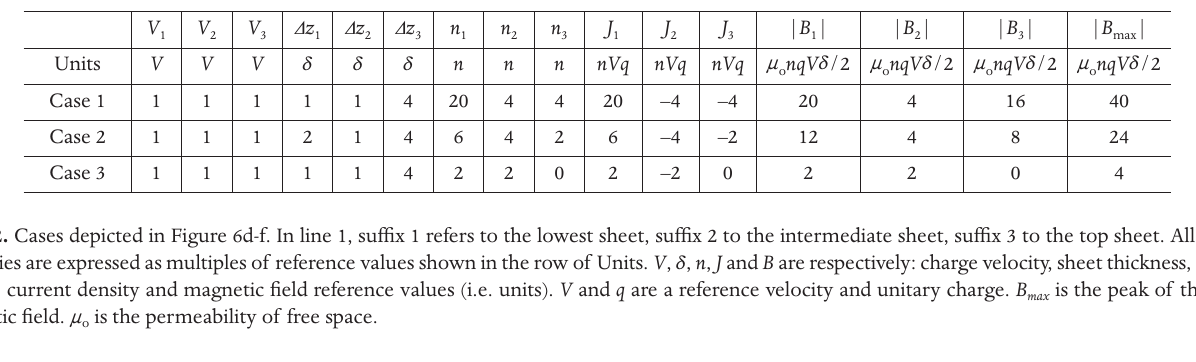
is the peak of the total max